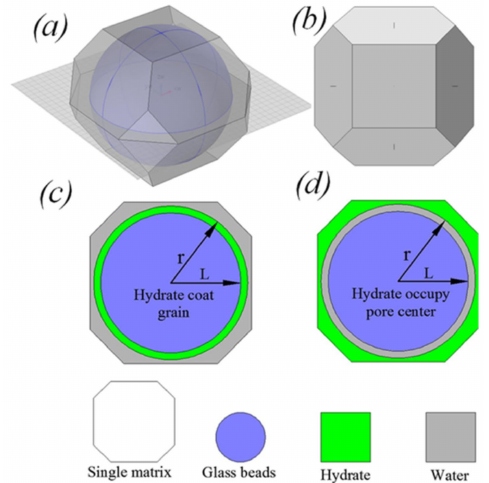
Figure 13. The models of hydrate coating grain and hydrate occupying pore center reprinted from [101] with permission from Elsevier. ( a ) A minimum repeatable matrix unit with purple glass bead in the center of a wedge tetrahedral; ( b ) the top view of the A minimum repeatable matrix